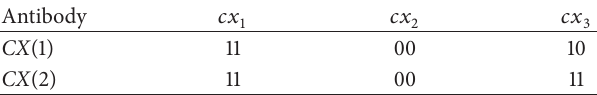
Table 2: The corresponding antibody of Table 1. Antibody